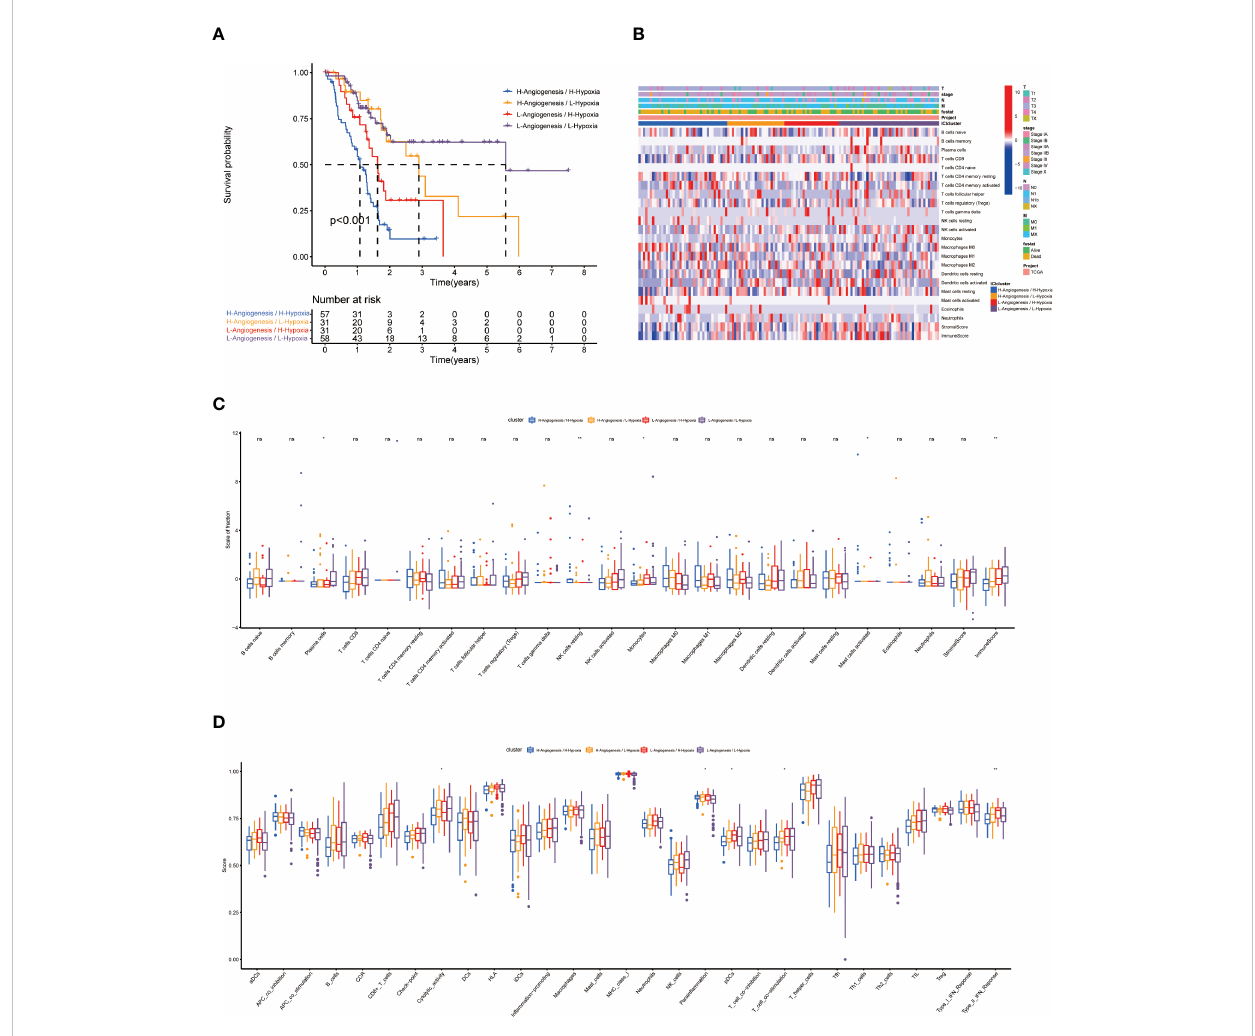
FIGURE 3 Prognosis and related immunological information for patients with 4 subtypes. (A) KM survival curves for 4 subtypes. (B) Heat map of the distribution of clinical information and immune cell ratios in 4 subtypes. (C, D) Differential analysis of immune cell ratios and immune cell function in 4 subtypes. * indicates a signi fi cant difference between groups, p<0.05; ** indicates a signi fi cant difference between groups, p<0.01; "NS" no signi fi cant difference between groups, p ≥